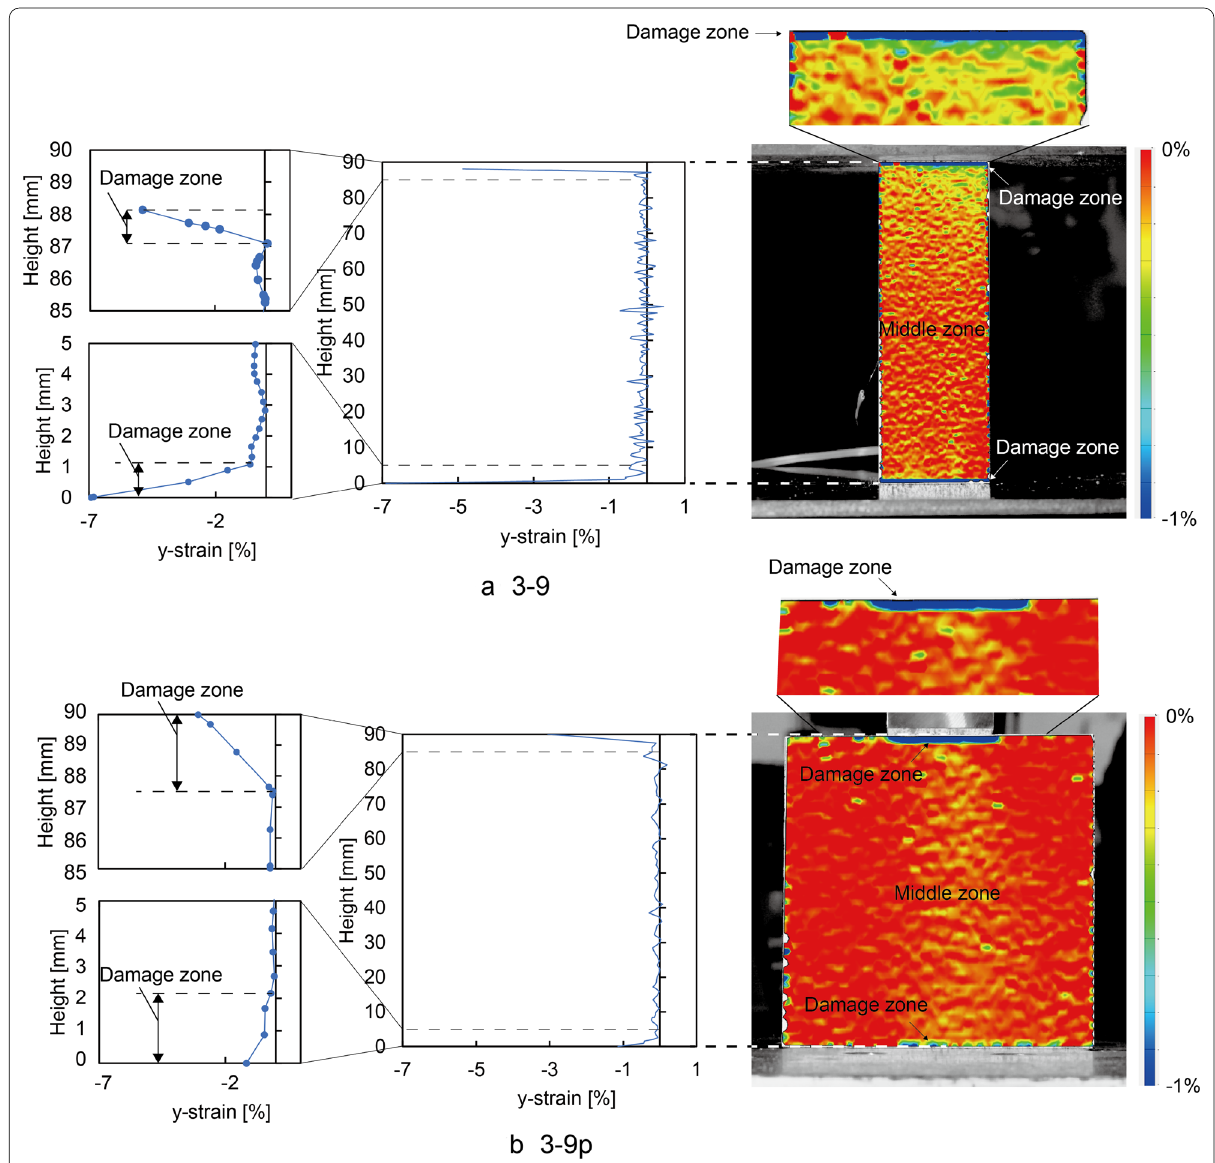
Fig. 6 Strain distribution of specimen no. 3-9 and 3-9p in Table 1 at 0.2 P